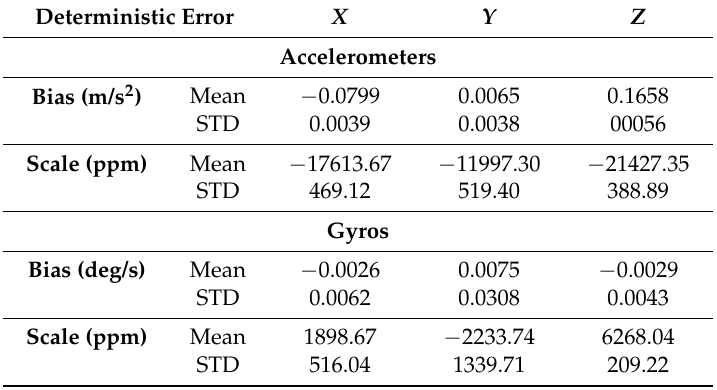
Table 1. The result of calibration.